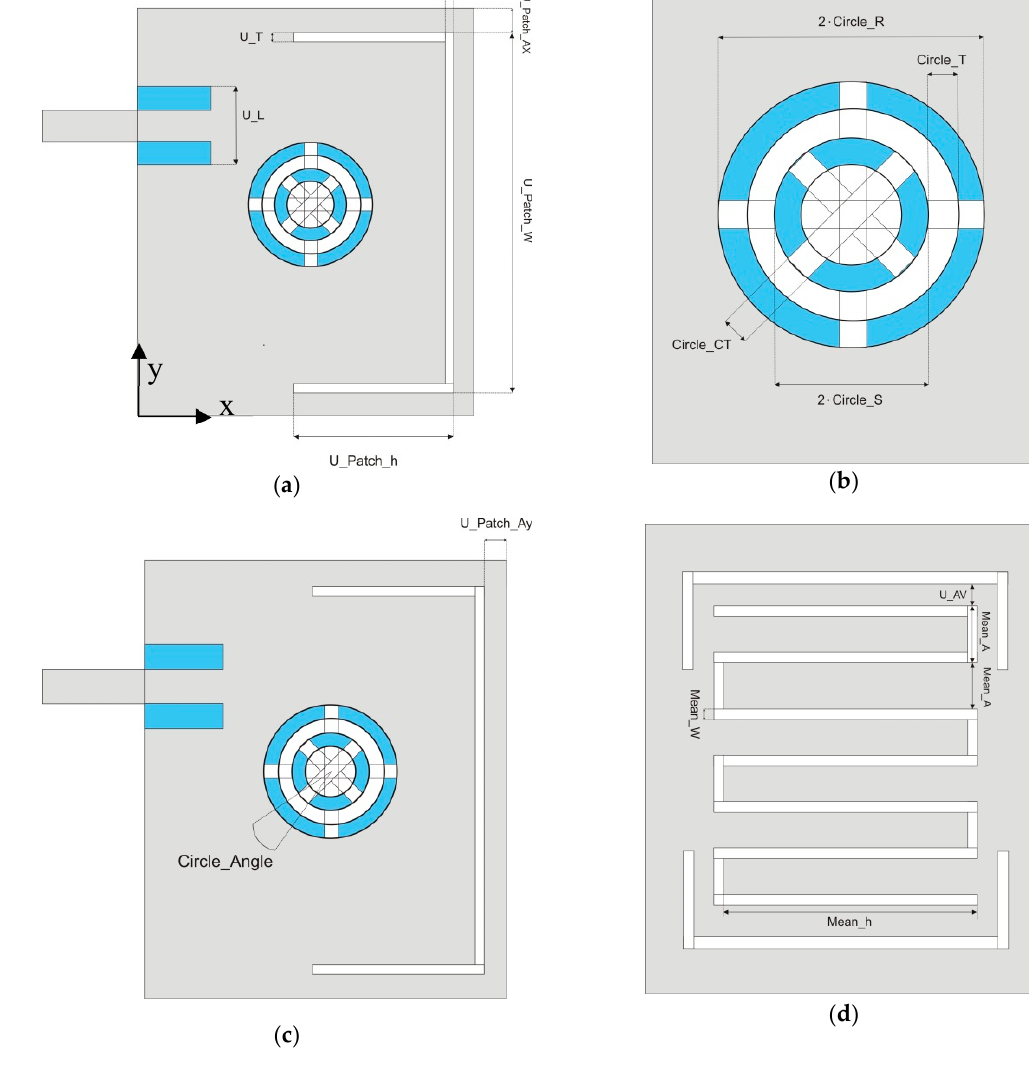
Figure 1. Variables description of the proposed antenna. ( a ) Antenna top view U-shaped variable description; ( b ) antenna top view the annular patch variable description; ( c ) detail description of the variables in the top view of the antenna that have been used in the optimization process; ( d ) antenna ground plane.